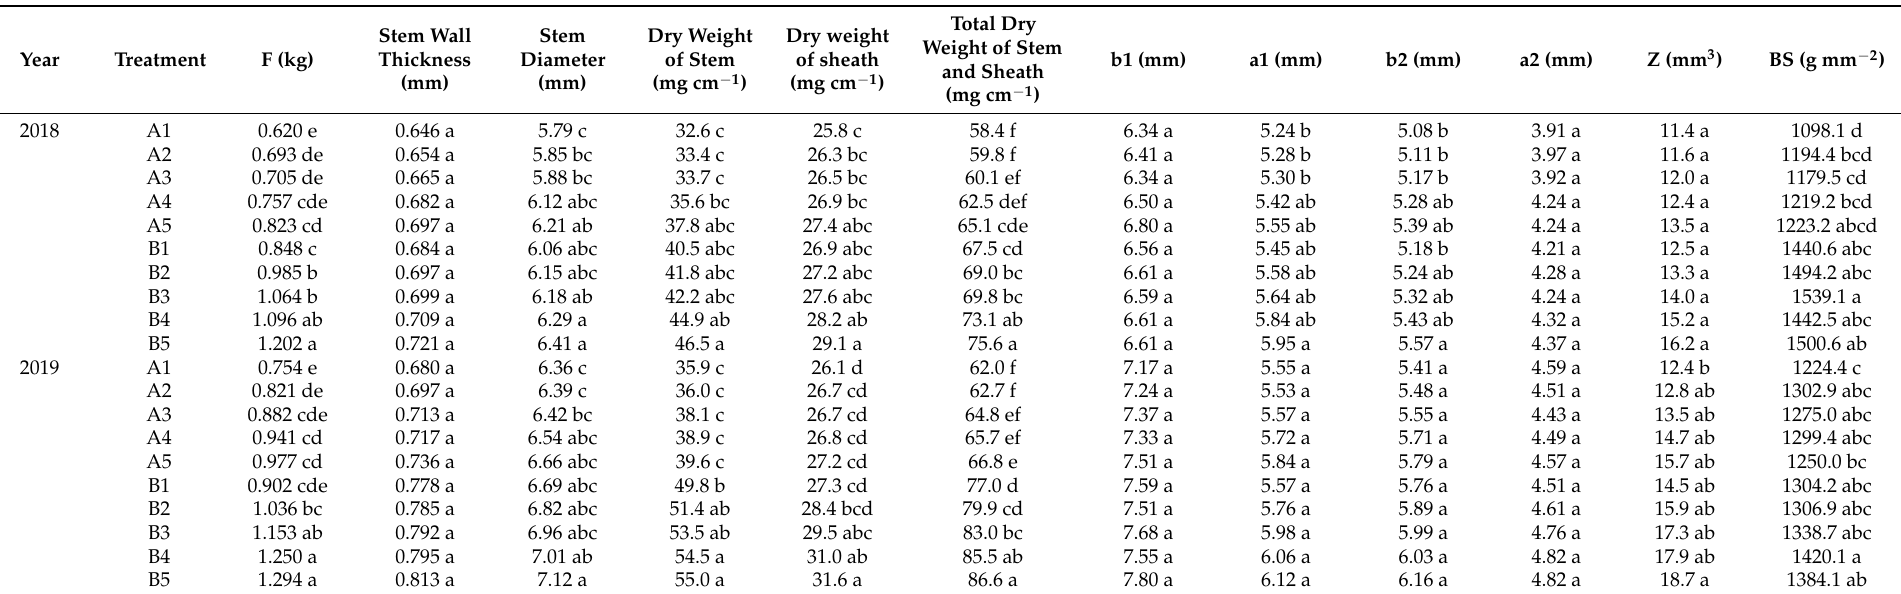
Table 5. Morphological characteristics of rice basal stem as affected by mechanical transplanting method and planting